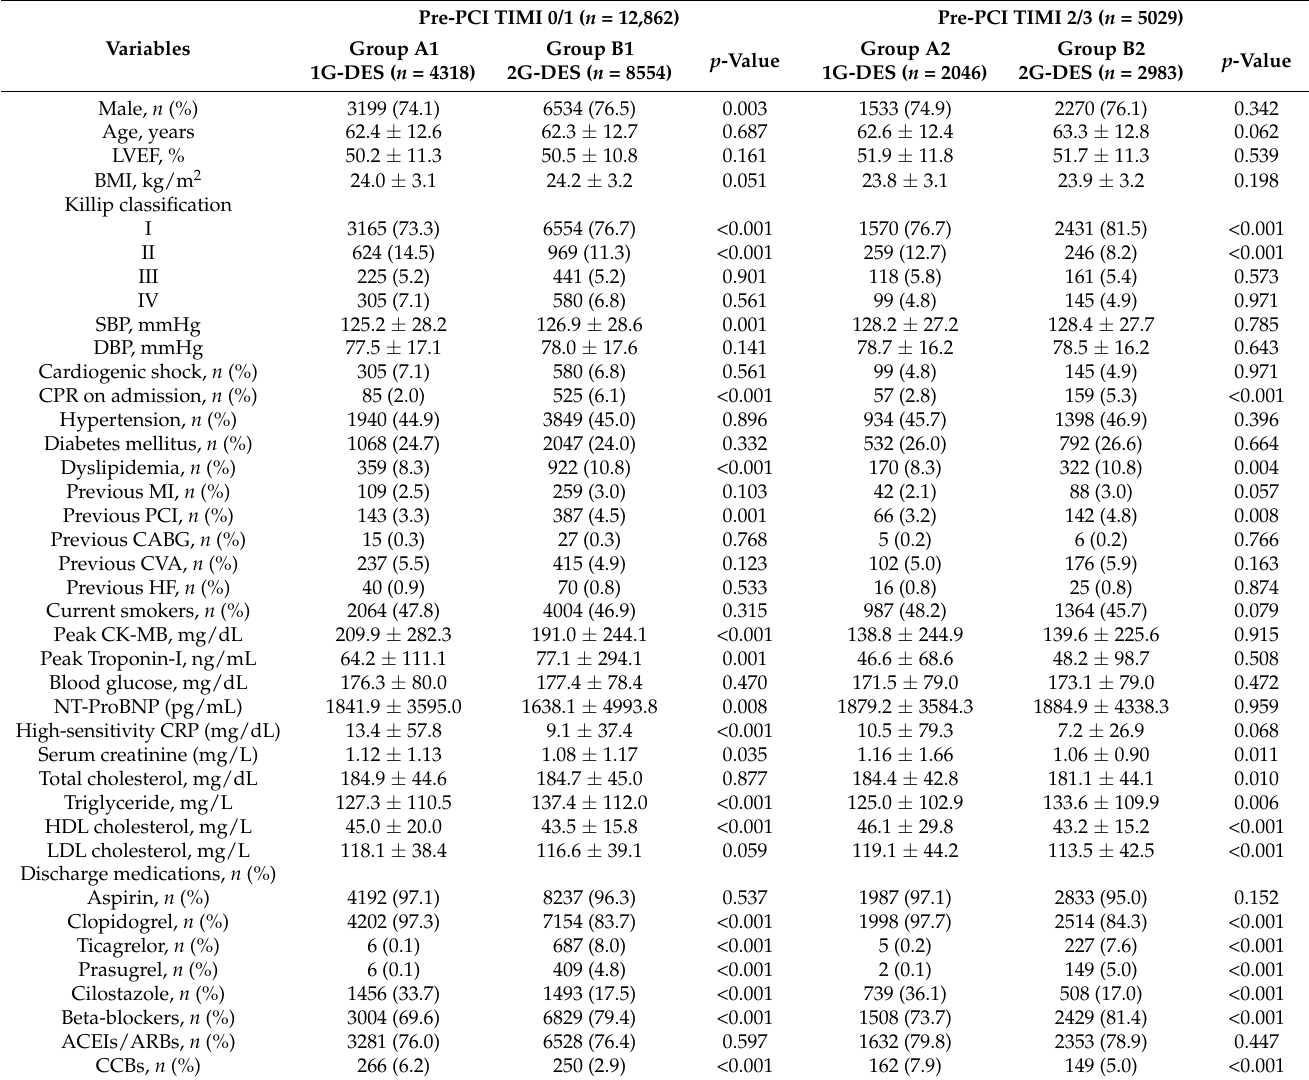
Table 1. Baseline